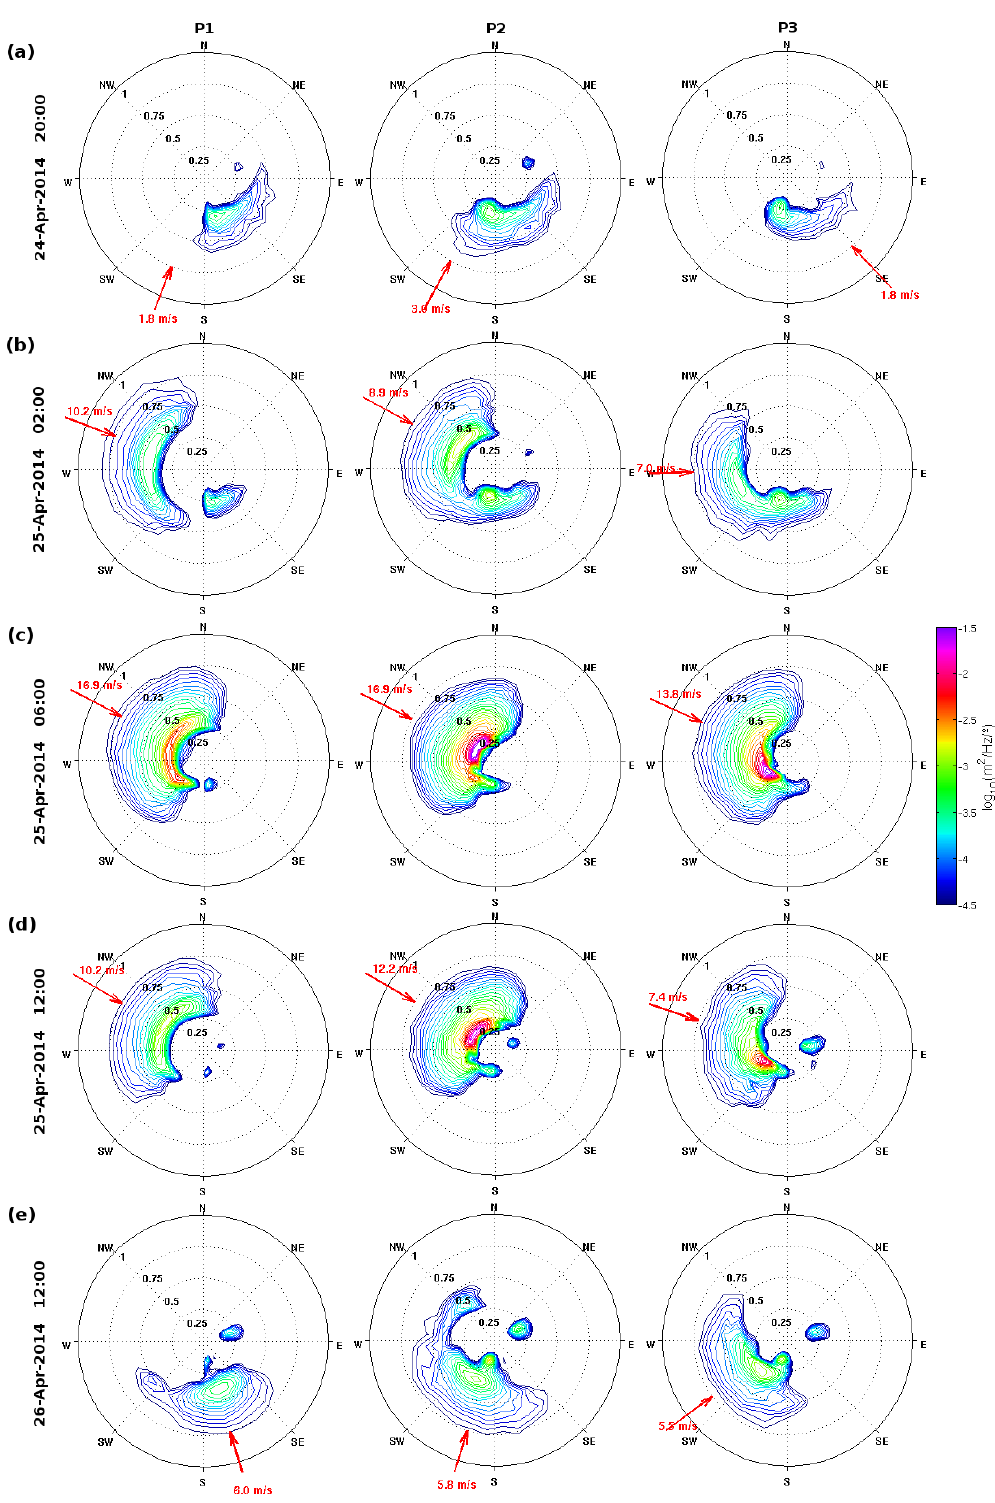
Figure 7. Evolution of the 2D variance density spectra during the wind-jet event E3 at P1 (first column), P2 (second column) and P3 (third column). Note that, in order to be able to compare the different spectra, the figure shows the logarithm of the variance density. The red arrows indicate the wind direction and intensity. Panels ( a – e ) show the time